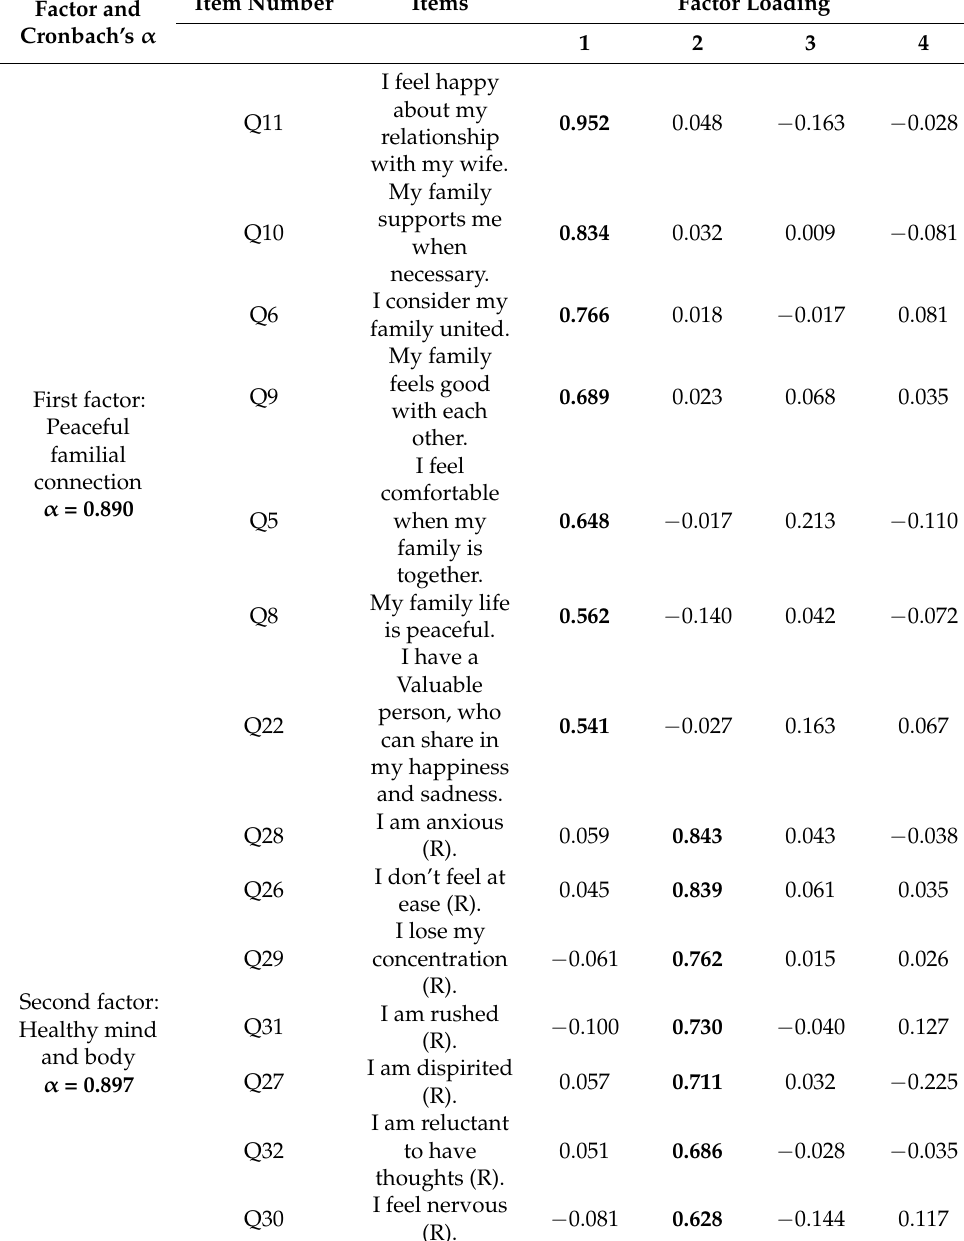
Table 3. Exploratory factor analysis of the MSCF (N =